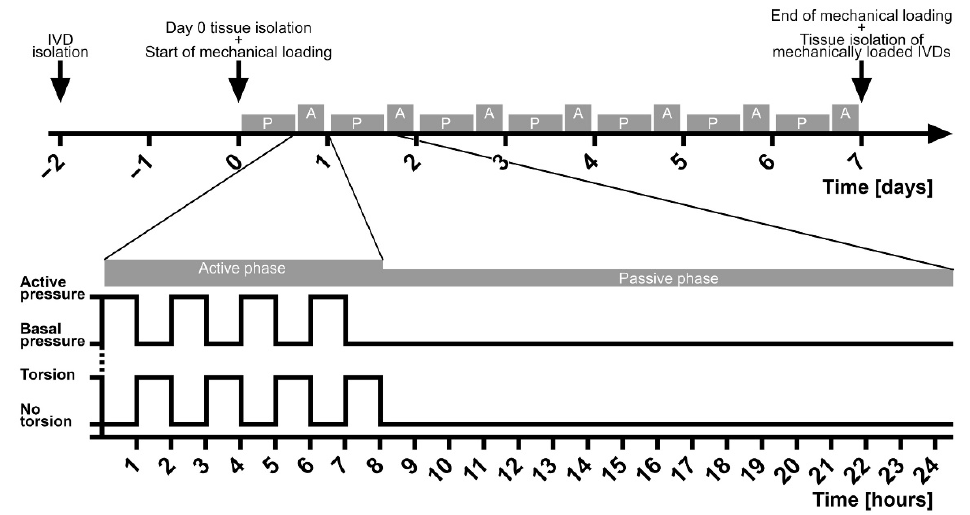
Figure 5. Experimental setup of the complex dynamic loading